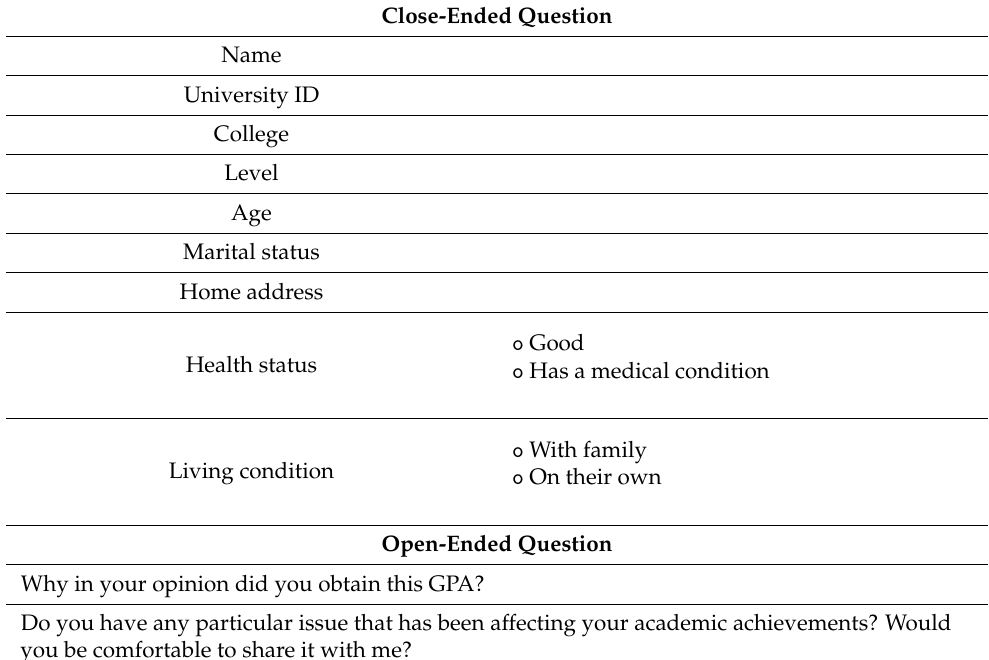
Table 1. Interview guide.